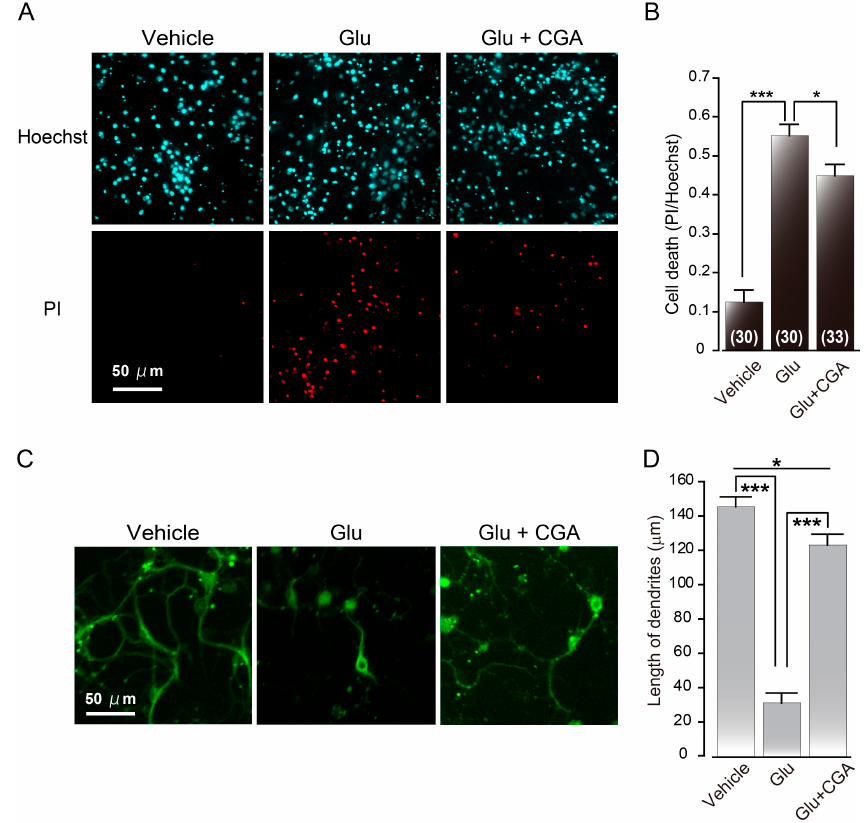
Figure 2. Effects of chlorogenic acid (CGA) on glutamate-induced neuronal cell death. ( A ) The extent of cell death was expressed as a ratio of the number of propidium iodide (PI)-positive cells to that of Hoechst-positive cells; ( B ) numbers in parentheses (30–33) indicate the number of determinations in each condition using different cultures; ( C ) cultured neurons stained with anti- β -III tubulin antibody. Neuronal cell death of cultured cerebral mouse neurons that were assayed following 16 h of treatment with 300 µ M glutamate (Glu) without or with 10 µ M CGA. Fluorescent immunohistochemistry was based on a modification of a previously described procedure [68–70]. All fluorescence microscopy images were obtained by laser confocal microscopy using a TCS SP8 (Leica Microsystems GmbH, Wetzlar, Germany). ImageJ software (National Institute of Health, Bethesda, MD, USA) was used to merge the obtained images; and ( D ) the length of the longest neurites of surviving neuronal cells was analyzed (number of cells: vehicle = 87; Glu = 38; CGA = 42). Data are expressed as mean ± standard error of mean (s.e.m.) * p < 0.05; *** p < 0.0001, t -test compared with treatment of 300 µ M Glu. Permission from Elsevier for ( A , B ): Mikami, Y.; Yamazawa, T. Chlorogenic acid, a polyphenol in coffee, protects neurons against glutamate neurotoxicity. Life Sci. 2015 , 139 , 69–74 [68].